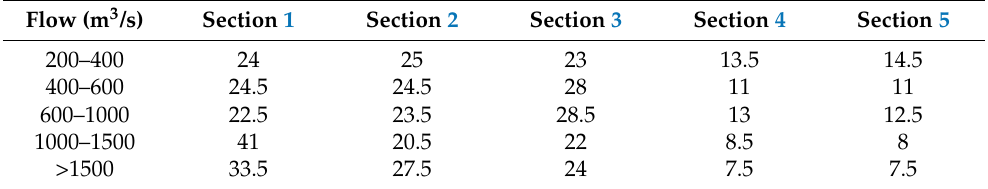
Table 4. Average proportion (%) of total off-channel inundation extent under different mainstem flows along five Sacramento River sections (defined in Figure 1).